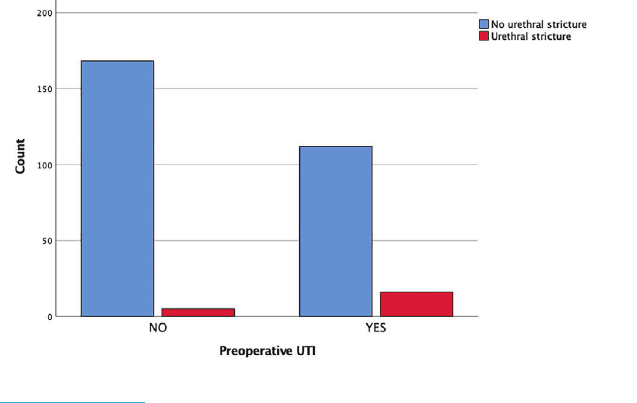
Spearman correlation analysis between the urethral stricture and